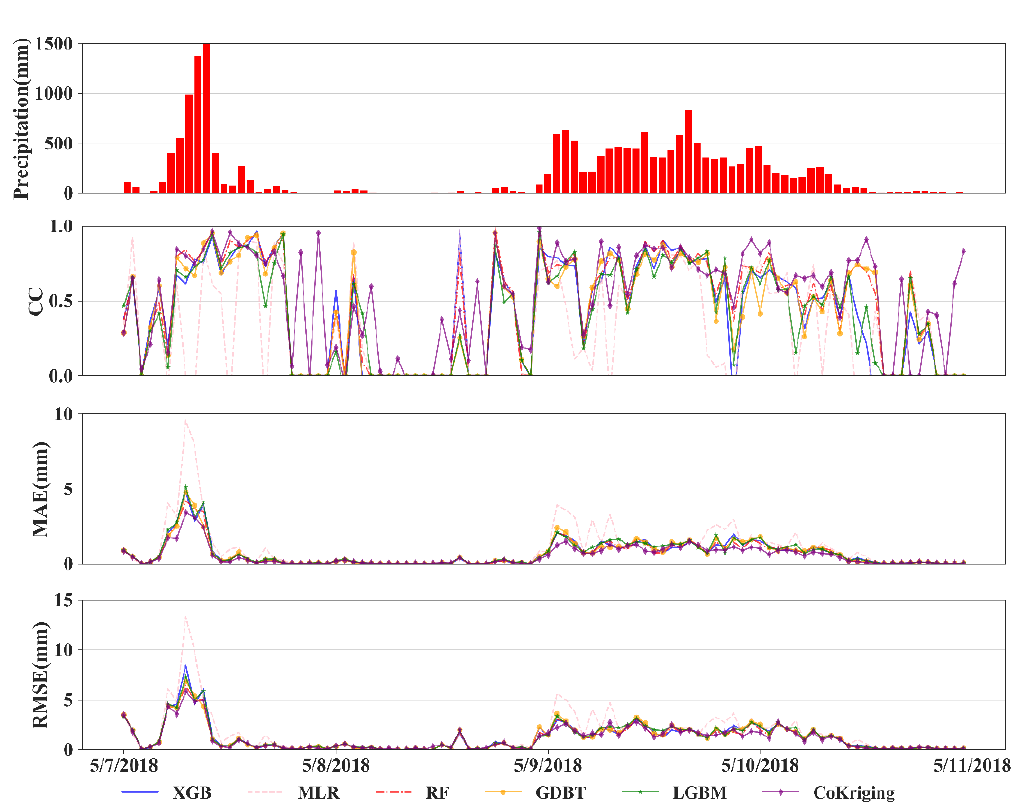
Figure 9. Evaluation indices of heavy rainfall event II.